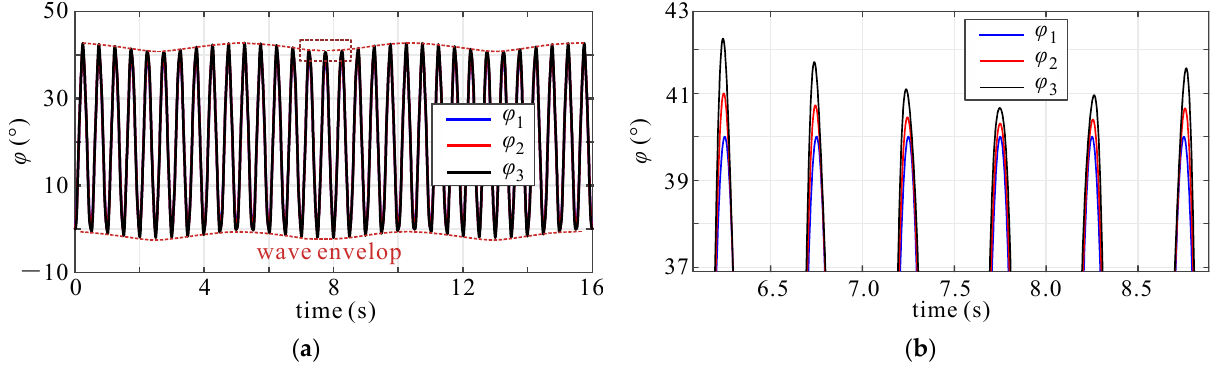
Figure 9. Stance phase, simulation results of ϕ 1 , ϕ 2 and ϕ 3 : ( a ) Values of ϕ 1 , ϕ 2 and ϕ 3 for the stance phase; ( b ) Enlarged view of the rectangular area in ( a ) .